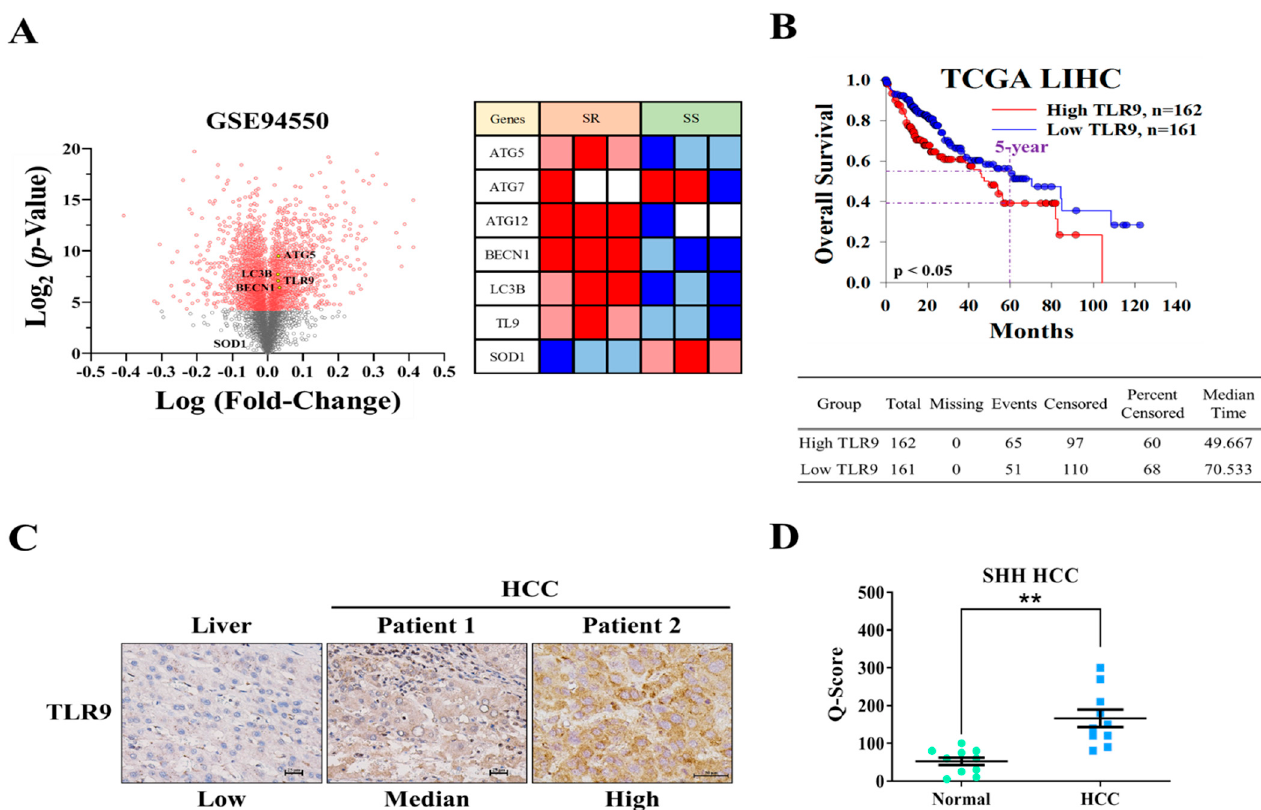
Figure 1. TLR9 was overexpressed in HCC sorafenib-resistant HCC tissue and cells. ( A ) Volcano plot shows differentially expressed genes in sorafenib resistance HCC (Huh7) cells (n = 3) and sensitive cells (n = 3) in GSE94550 GEO datasets. Heatmap illustrates the expression of TLR9 and other important genes associated with HCC sorafenib-resistant cells (right panel). ( B ) Kaplan–Meier curves indicating the correlation of TLR9 expression and the overall 5-year survival of TCGA LIHC patients. ( C ) Immunohistochemistry indicated a higher expression of TLR9 in the HCC tumor tissues. ( D ) Scatter plot reflecting the intensity of TLR9 staining in normal (n = 10) and tumor settings (HCC, n = 10), ** p < 0.01. Scale bar: 50 µ